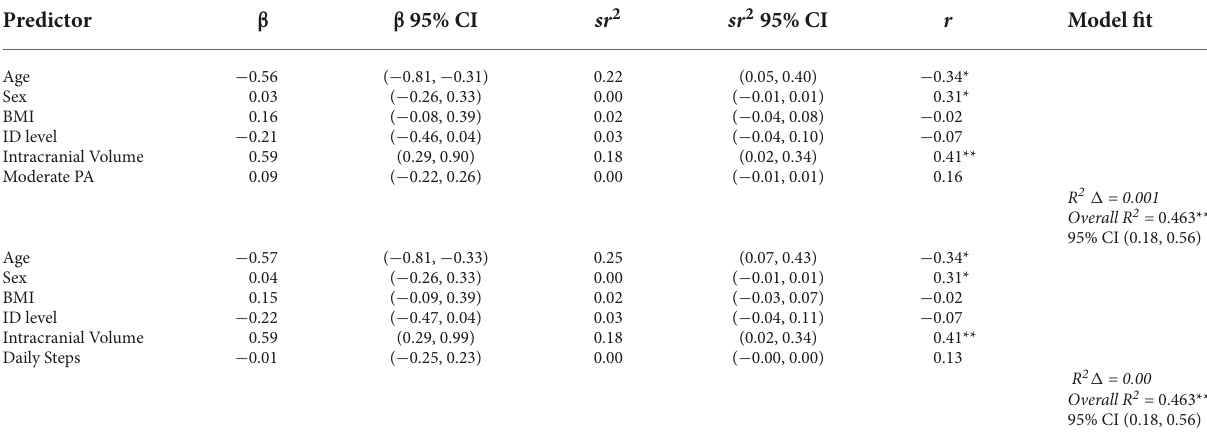
TABLE 5 Regression models of the relationships between physical activity variables and hippocampal volume ( n = 54). Predictor β β 95% CI sr